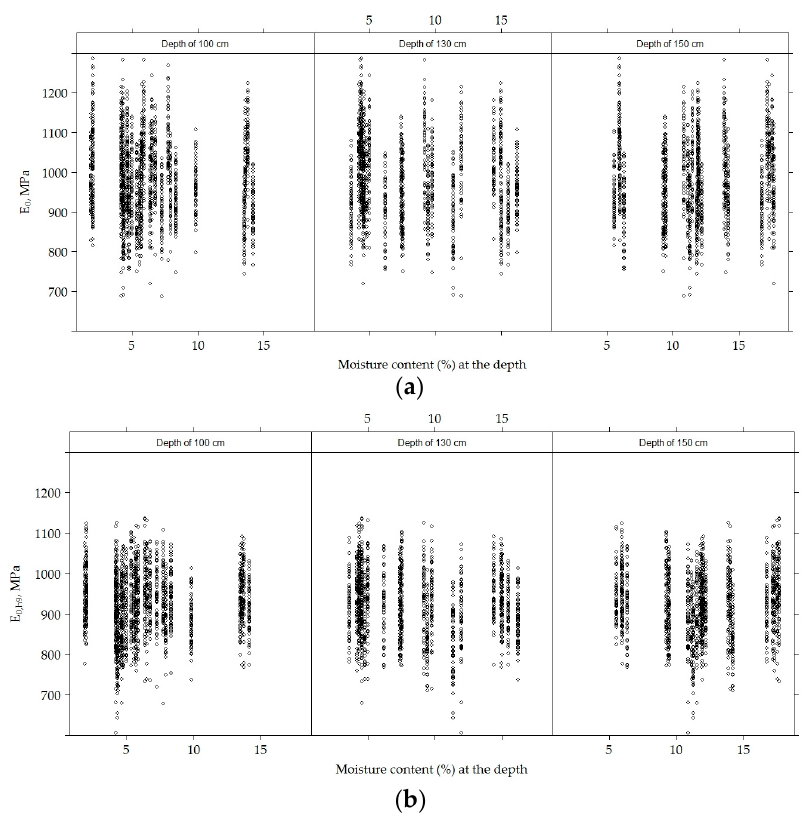
Figure 24. Scatter plots for E 0 ( a ) and E 0,h9 ( b ) values and moisture content at a given depth.